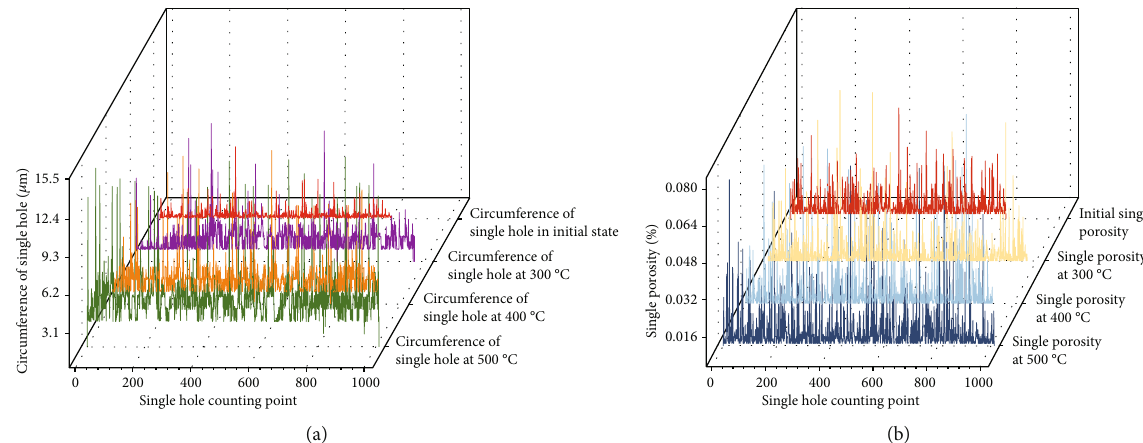
Figure 14: Changes in pores and cracks of oil shale under microwave heating. (a) Curve of changes in the perimeter of a single pore of the oil shale sample. (b) Curve of changes in a single pore of the oil shale sample.